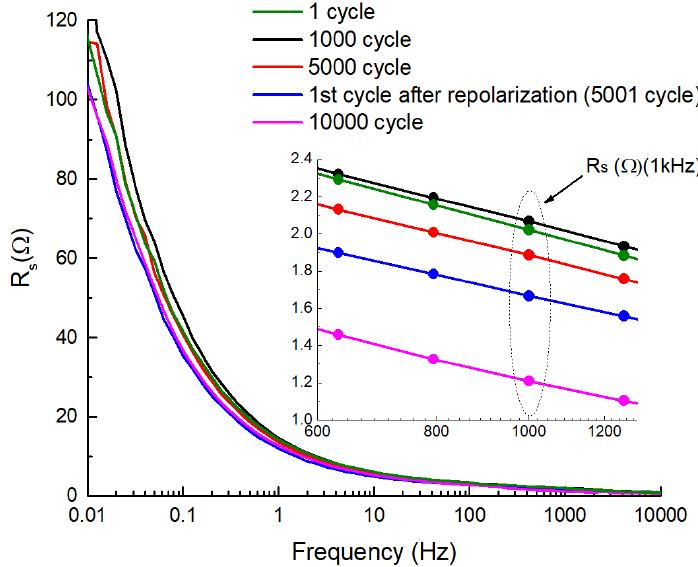
Figure 5. Series resistance R s vs. frequency of the 2-electrode cell at 1.5V.